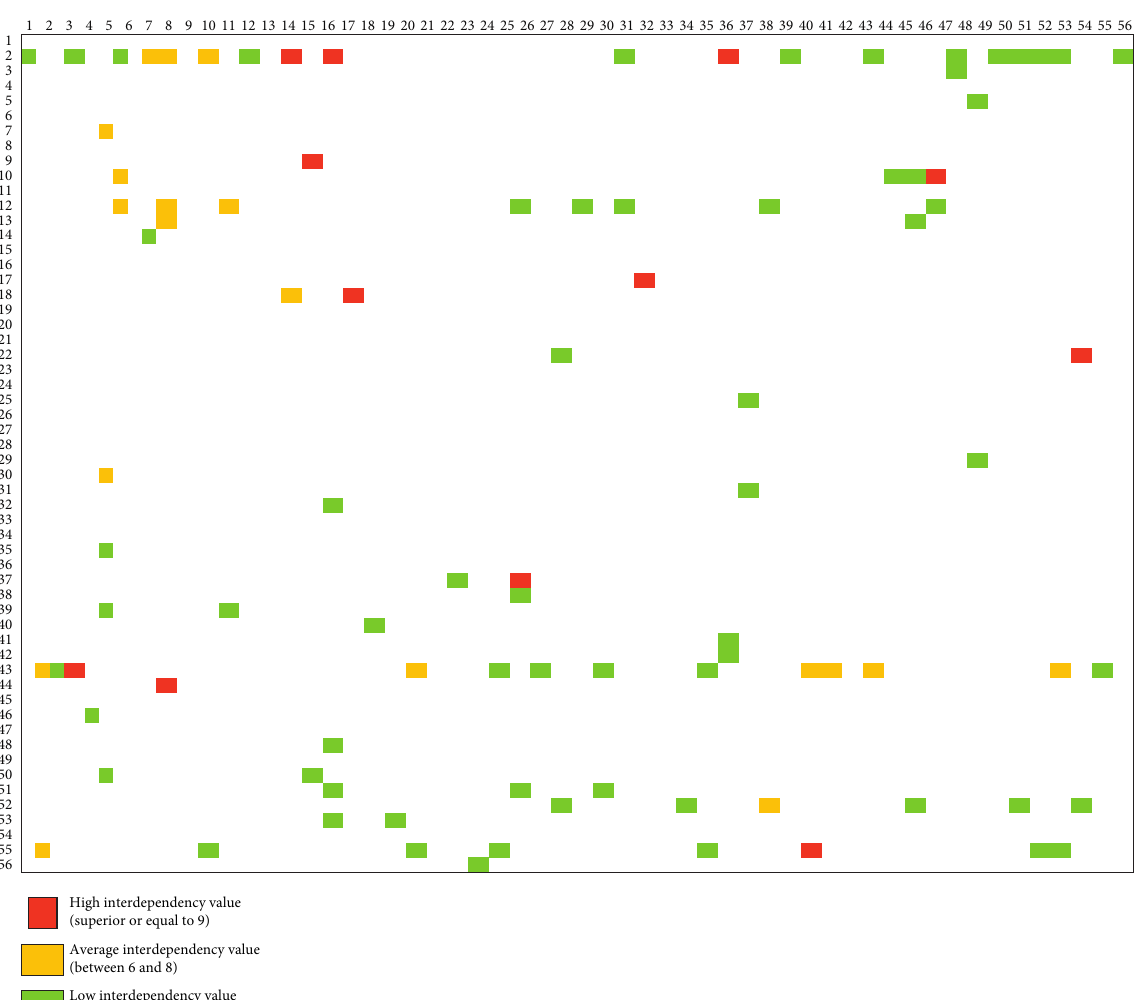
Figure 3: Illustration of the assessment of the 95 interdependencies between the 56 risks of the tramway